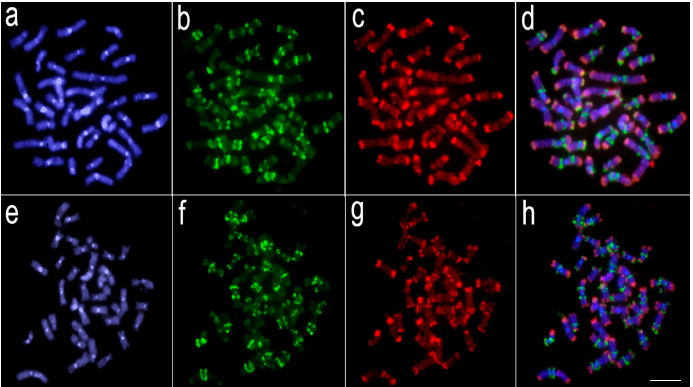
Figure 3. Comparative genomic hybridization using the gDNA of Lebiasina melanoguttata , Copeina guttata, and Copella nattereri against the chromosomal background of Lebiasina melanoguttata . Genomic probes from L. melanoguttata and Copeina guttata hybridized against L. melanoguttata chromosomes ( a – d ). Genomic probes from L. melanoguttata and Copella nattereri hybridized against L. melanoguttata chromosomes ( e – h ). The first column ( a and e ): DAPI images (blue); second column ( b and f ): hybridization patterns using gDNA probe from L. melanoguttata ; third column ( c and g ): hybridization patterns using gDNA probes from Copeina guttata and Copella nattereri , respectively; fourth column ( d and h ) merged images of both genomic probes and DAPI staining depicting the common regions in yellow. Scale bar = 5 μ m.